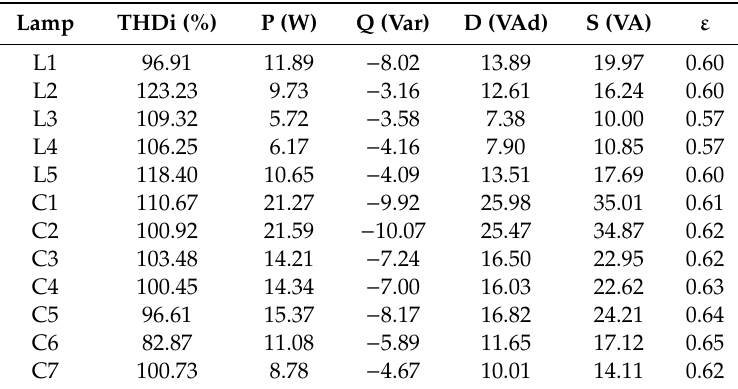
Table 5. Calculated values for the twelve